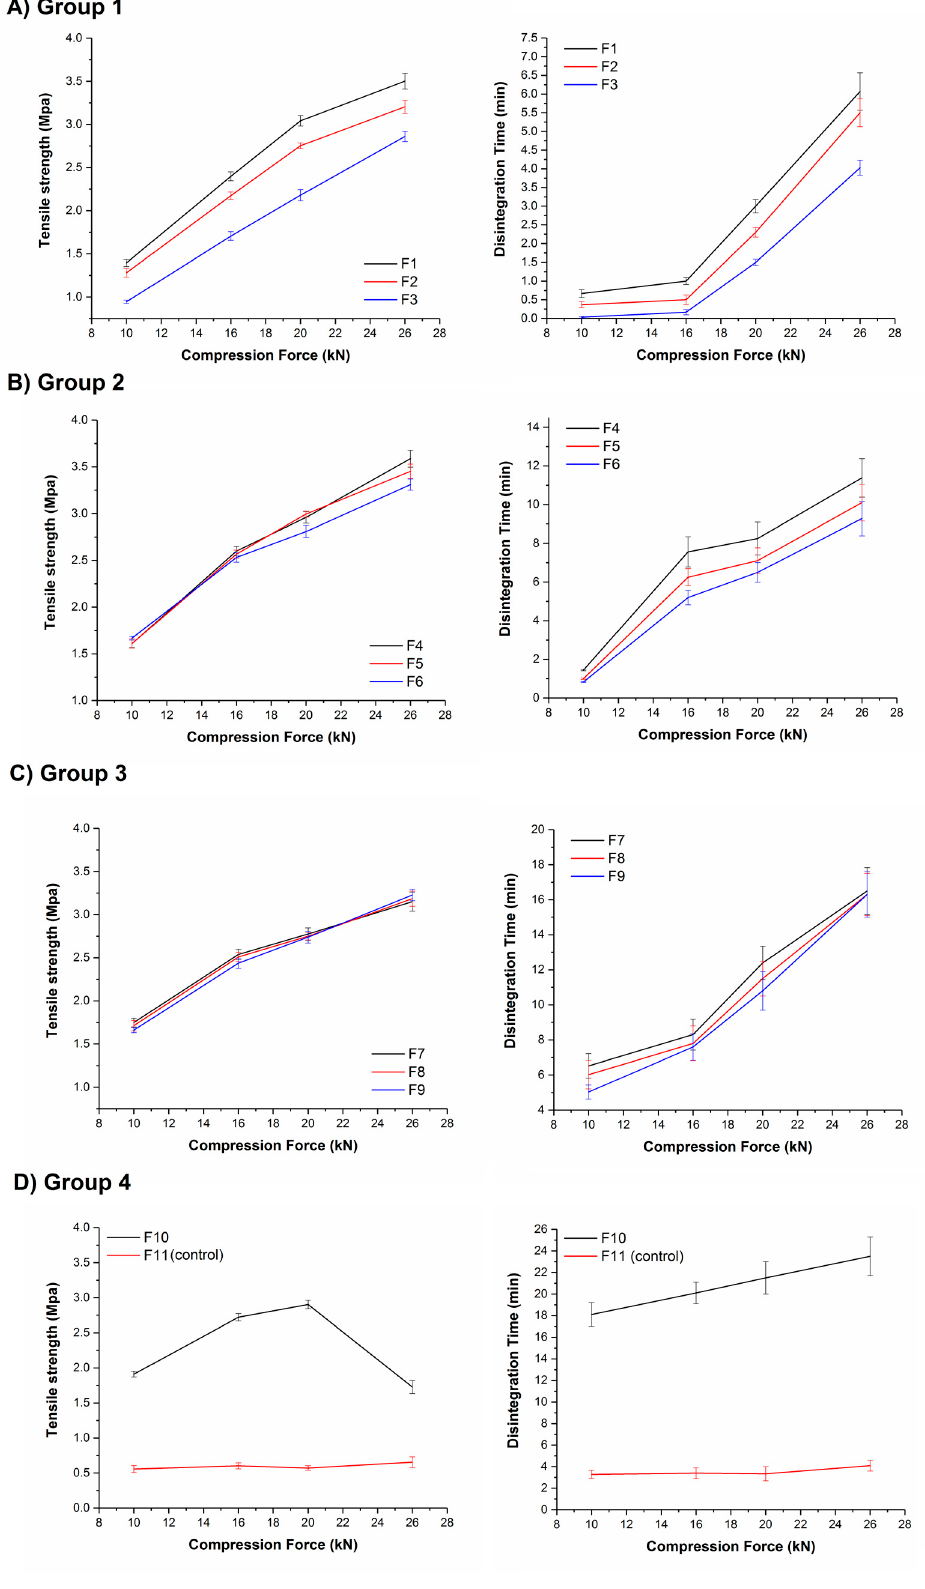
Figure 9. Tensile strength and disintegration time profiles as a function of compression force applied for tablets belonging to ( A ) Group 1, ( B ) Group 2, ( C ) Group 3, and ( D ) Group 4.